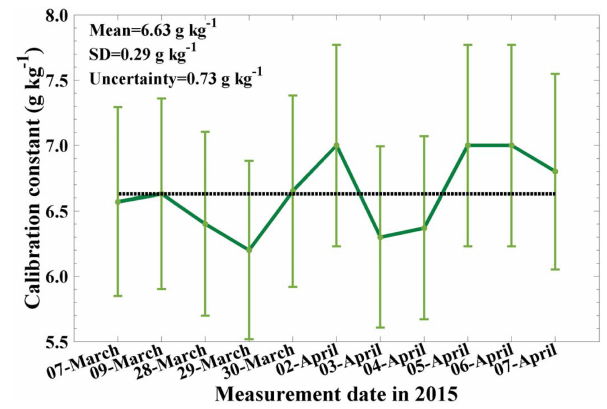
Figure 8. Calibration constants ( C ) determined for 11 pairs of lidar and (sun and) lunar photometer observations by using Eq. (8) in the 11 selected measurements (thick, green solid line). The error bar shows the overall retrieval error (see Appendix B, Eq. B3). The dot- ted line shows the mean value of all the 11 nighttime calibrations.